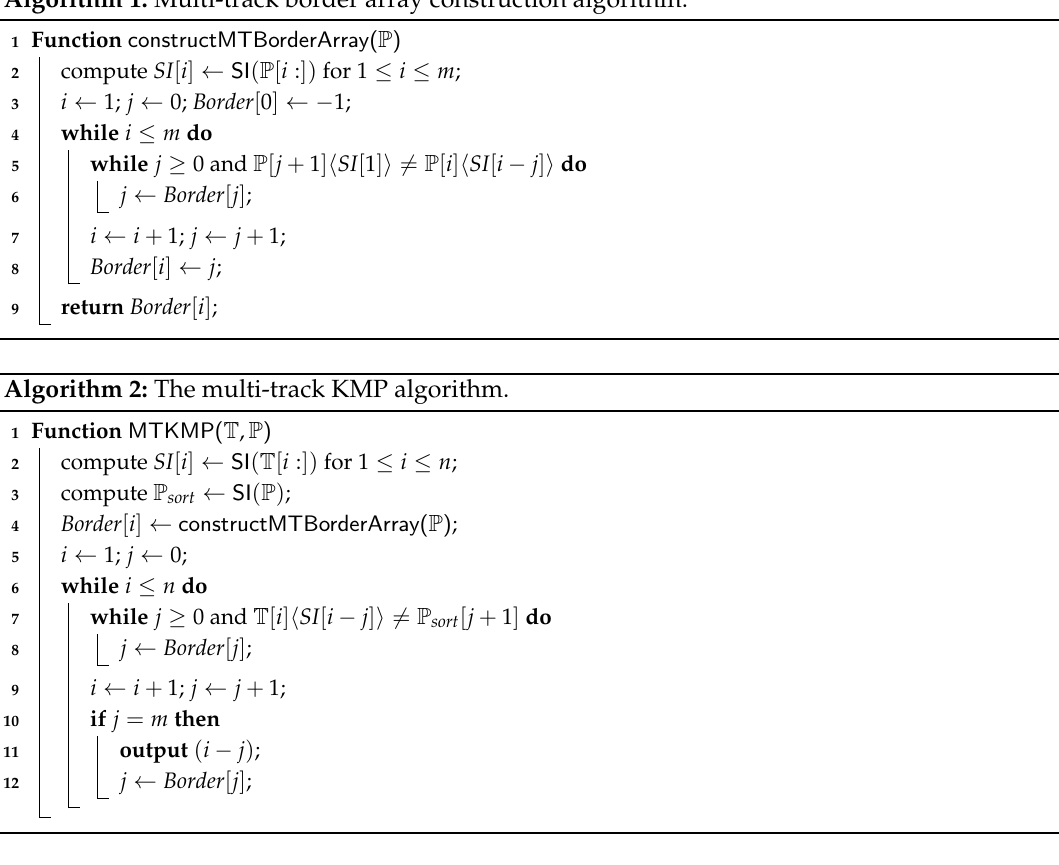
Algorithm 1: Multi-track border array construction algorithm.